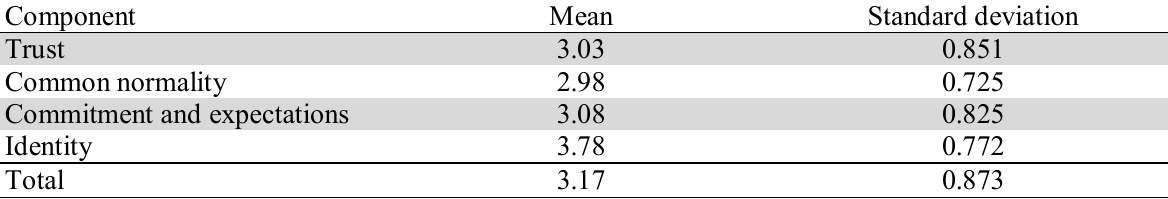
Mean and standard deviation of relational components of social capital Component Trust